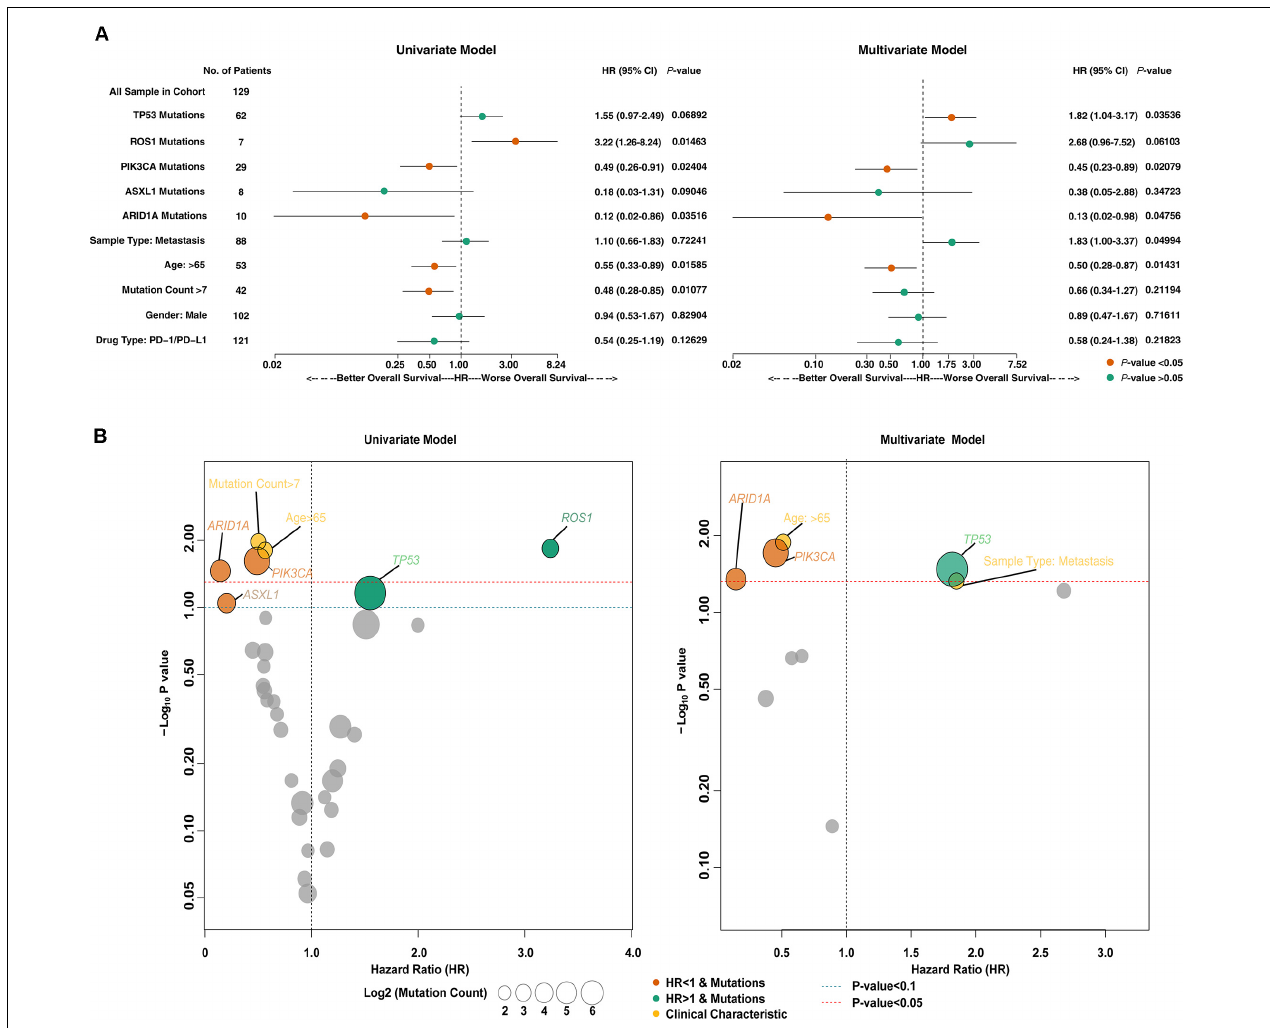
FIGURE 1 | The predictive value of clinical characteristics and mutant genes on ICIs efficacy. (A) Forest plots for the results of the univariate (left panel) and multivariate (right panel) Cox regression analyses. In the univariate Cox regression analysis, the factors with a p -value less than 0.1 were age, mutation count, and mutations in ROS1, PIK3CA, ARID1A, TP53, and ASXL1. The multivariate Cox regression analysis showed that age and ARID1A, PIK3CA, and TP53 mutations were independent predictors of ICI therapy in HNSC patients. The main portion of the forest plot presents the hazard ratio (HR) and 95% confidence interval (95% CI), where red dots indicate p < 0.05. The HR indicates the predictors of favorable (HR < 1) or poor (HR > 1) OS. (B) Bubble plots were used to visualize the results of the univariate (left panel) and multivariate (right panel) Cox regression analyses. The blue and red dashed lines indicate p -values of 0.1 and 0.05, respectively. The size of the circle indicates the mutation count. The gray circles represent variables with p < 0.1 (left panel) or p < 0.05 (right panel), and the yellow circles represent the clinical characteristics of patients. The color of other circles represents the gene mutations associated with a good (orange; HR < 1) or poor (green; HR < 1)